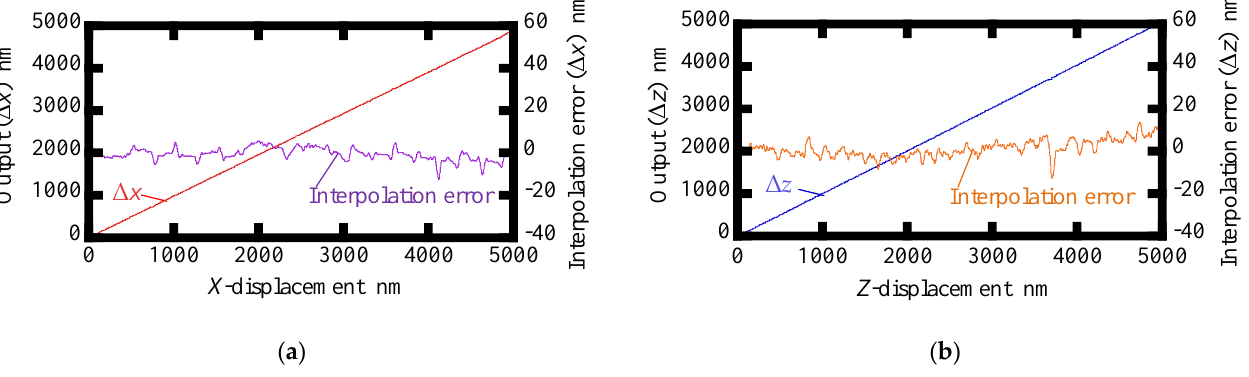
Figure 10. Interpolation errors of the proposed method of this research: ( a ) Interpolation error in X -axis displacement measurement; ( b ) Interpolation error in Z -axis displacement measurement. Experiments were expanded to confirm the measuring range of the proposed surface encoder along the Z -axis. Figure 11 shows the experimental setup. At the initial setup, the gap between the scale and the sensor head was set to be 9 mm. A Z - directional offset Δ wd of 1 mm step was then applied to the scale grating by XZ manual stage2. At every position of the scale grating, the basic performances of the surface encoder were tested.